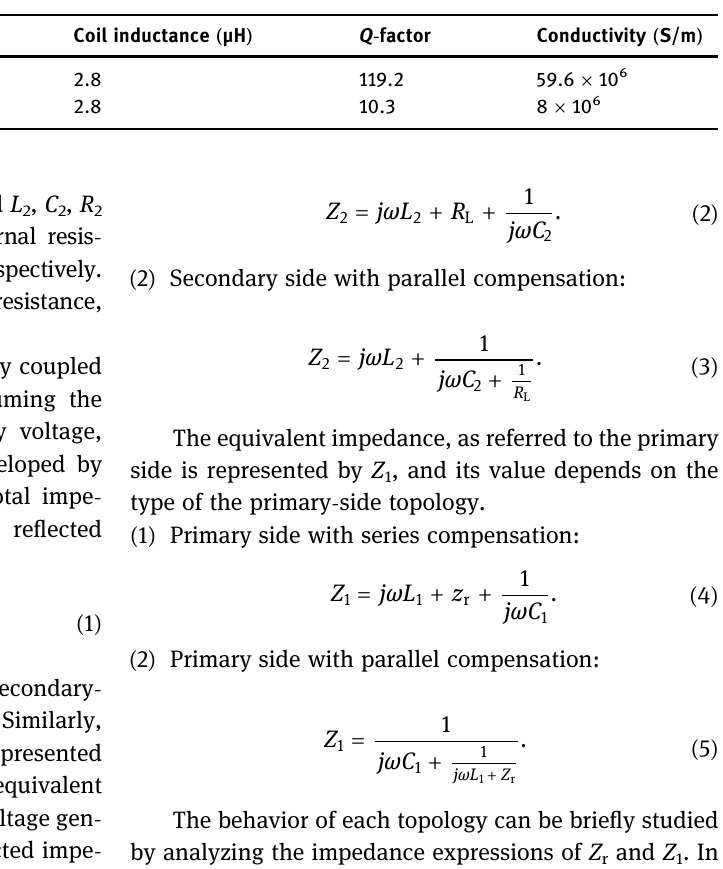
dances are observed for di ff erent types of compensation.